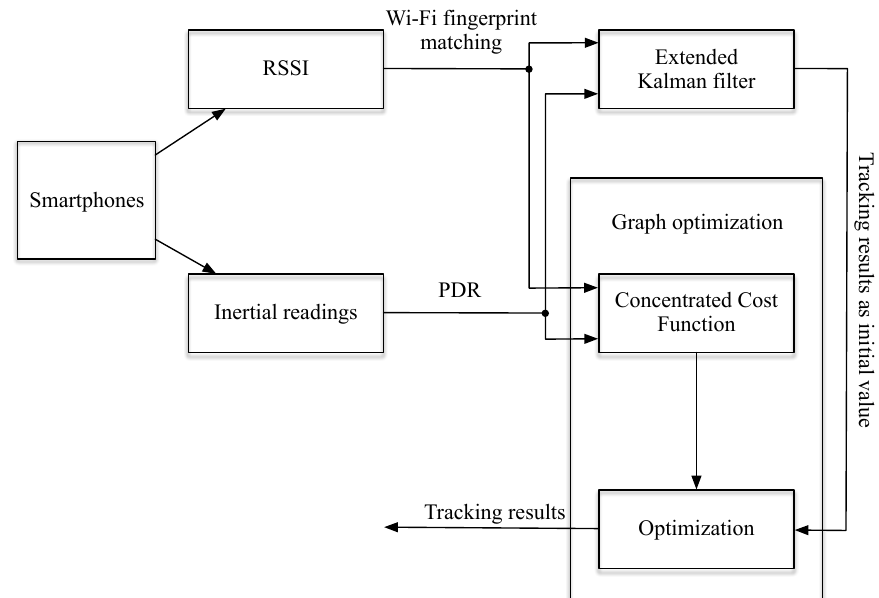
Figure 1. The framework of the proposed method for pedestrian tracking adopting Wi-Fi Received Signal Strength Indication (RSSI) and inertial measurements from a